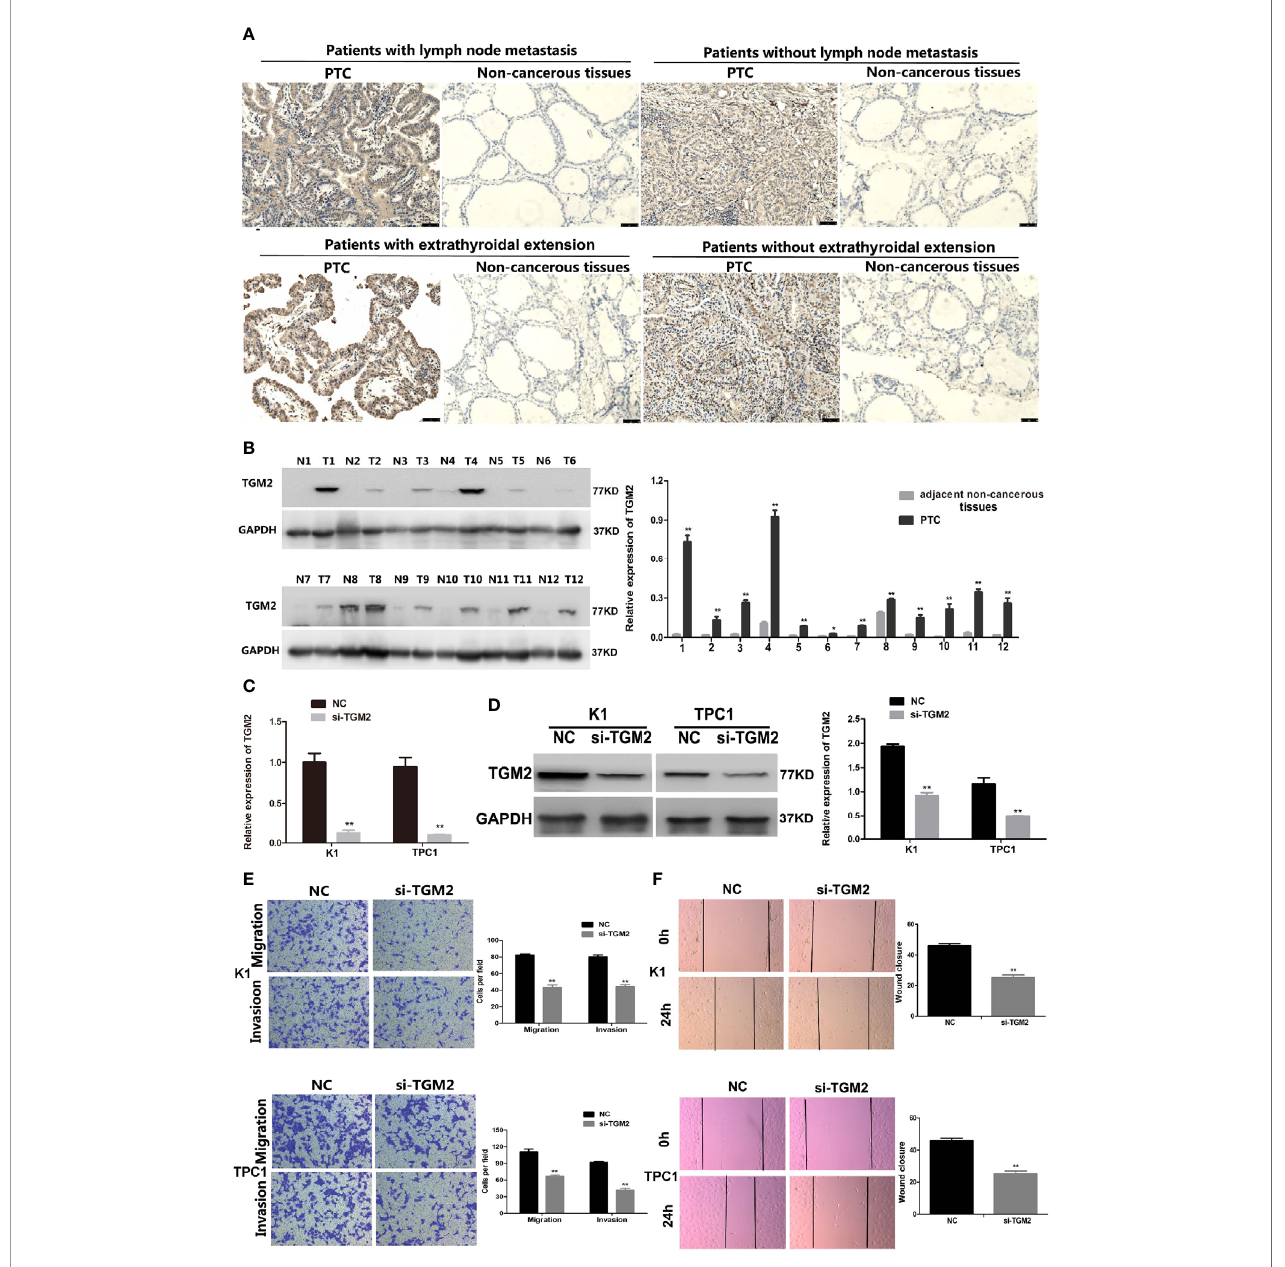
FIGURE 2 | Upregulation of TGM2 expression promoted the migration and invasion of PTC cells. (A) Representative photographs from IHC analysis of TGM2 protein levels in normal and tumor samples, with or without lymph node metastasis and extrathyroidal extension. Scale bars: 50 m m. (B) Western blotting analysis of relative TGM2 protein levels in 12 pairs of PTC tissues (T) and corresponding adjacent non-cancerous tissues (N). *P < 0.05, **P < 0.01 versus adjacent non- cancerous tissues. (C) The relative mRNA expression of TGM2 was detected using qRT-PCR in PTC cells after transfection with si-TGM2 or NC. Data are presented as the mean ± S.D., as analyzed using an independent samples t-test. **P < 0.01 versus NC. (D) Western blotting was applied to detect the protein level of TGM2 in PTC cells transfected with si-TGM2 or NC. Data are presented as the mean ± S.D., as analyzed using an independent samples t-test. **P < 0.01 versus NC. (E) Transwell assays were used to evaluate the migration and invasion in PTC cells after transfection with si-TGM2 or NC. Data are presented as the mean ± S.D., as analyzed using an samples t-test. **P < 0.01 versus NC. (F) A wound healing assay was applied to analyze the migration capacity in PTC cells after transfection with si-TGM2 or NC. All data are presented as the mean ±